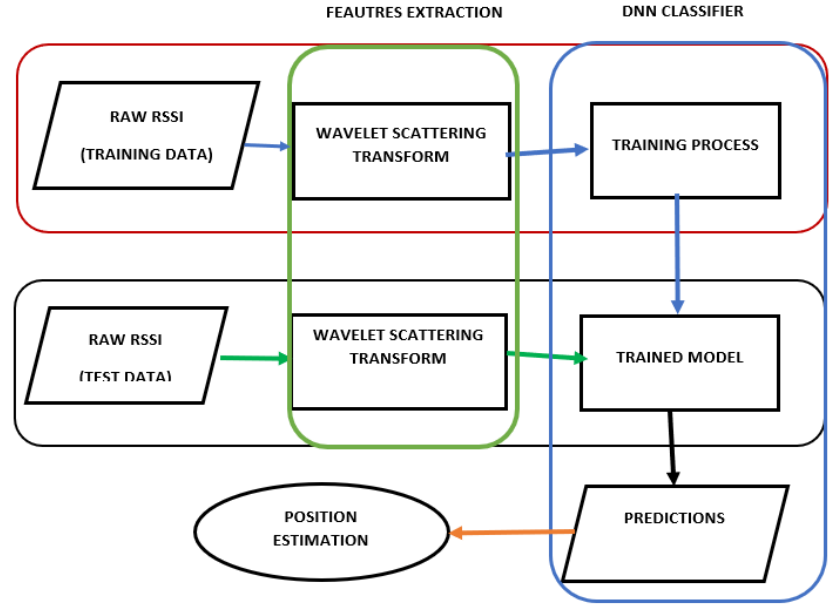
Figure 1. Proposed system architecture.